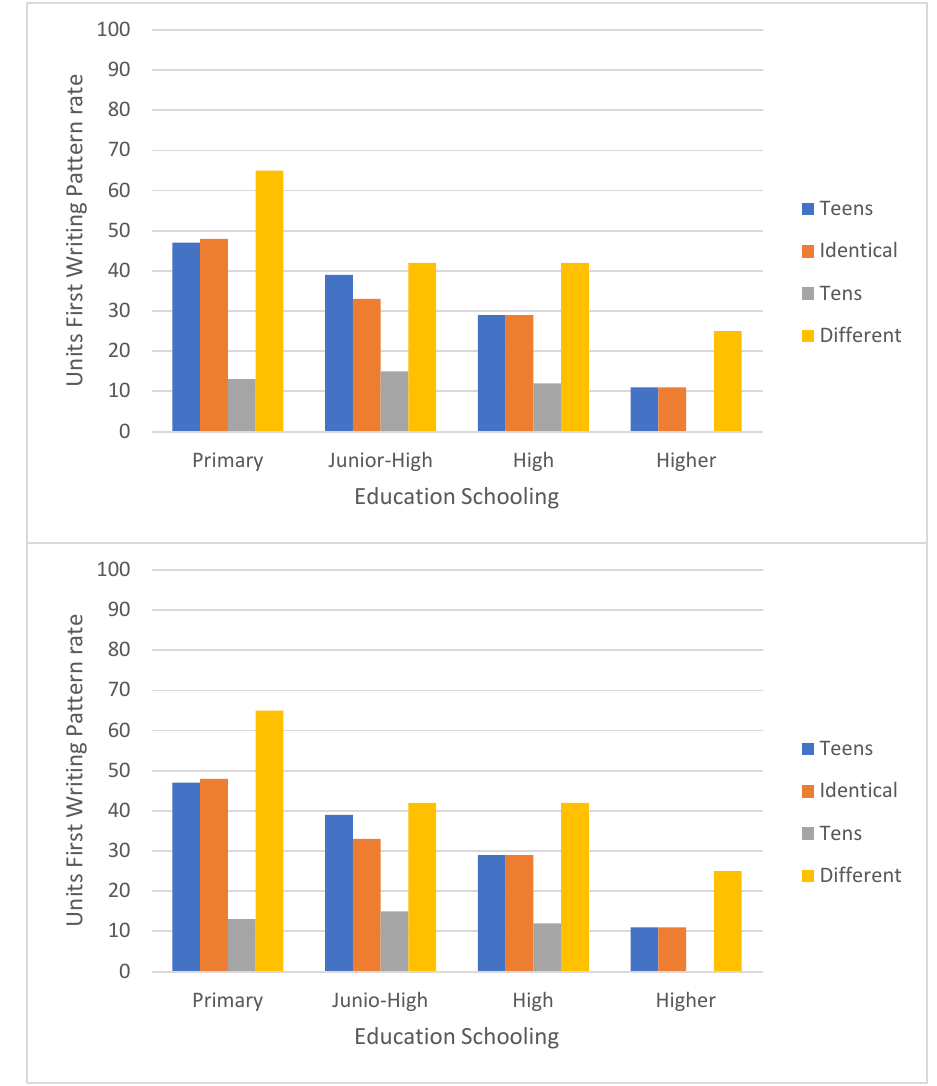
Figure 3. The units-first (right to left) writing pattern rates as a function of two-digit numbers category (teens, identical, tens and different) and educational level (primary, junior-high, high, higher).